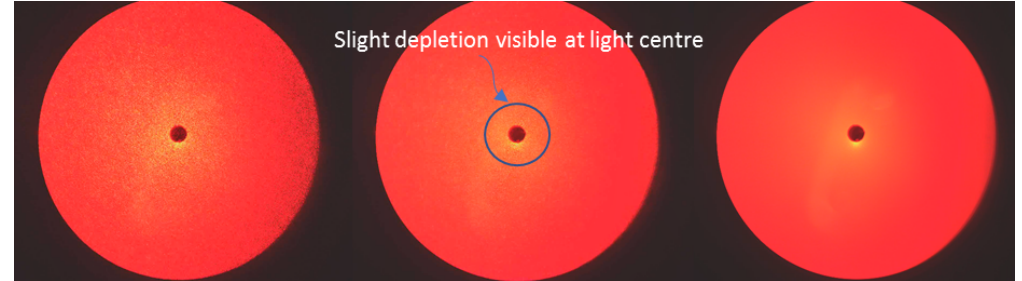
Figure 14: Untreated UT GCC in linseed oil, 3 w/w% solids, under shear between parallel counter-rotating plates, gap 0.3 mm: left to right low shear under ramp-up, high shear, and low shear under ramp-down, respectively.